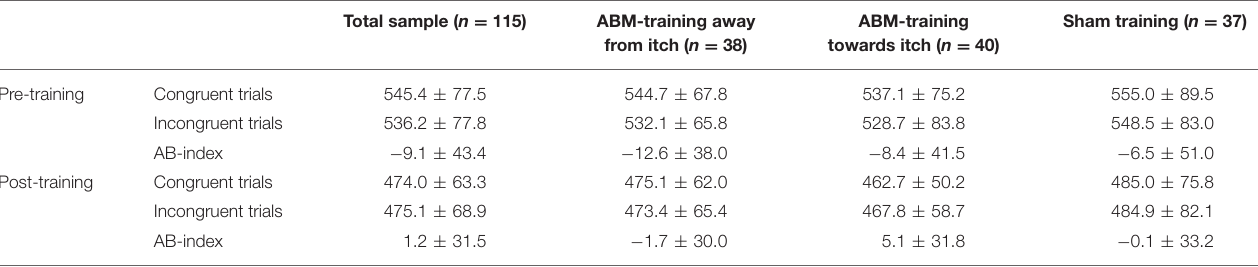
Table 3A | Mean ± standard deviation of reaction times for the trials congruent and incongruent to the itch pictures of the dot-probe tasks administered pre- and post-attention bias modification (ABM)-training, displayed for the total sample and per training condition.